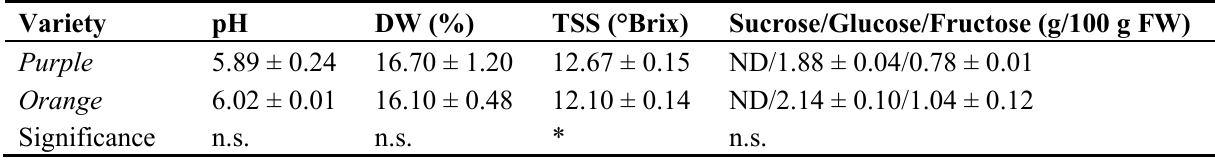
Table 1. Physico-chemical parameters measured in the two prickly pear fruit varieties. Results are means ± S.D. ( n =